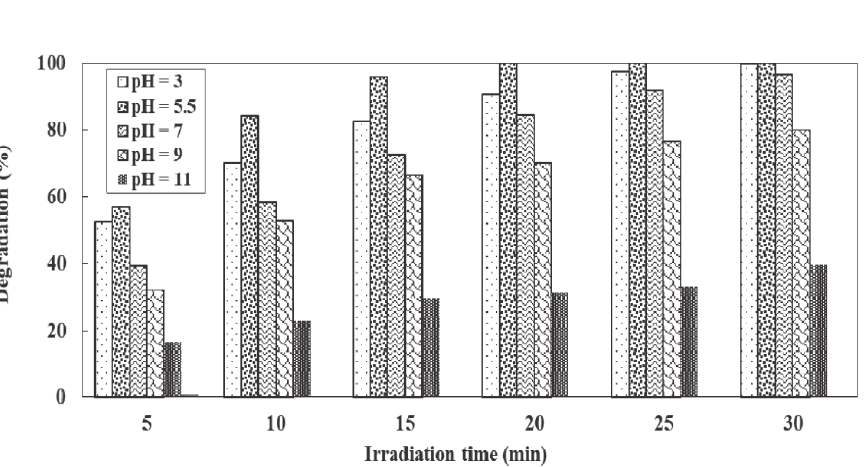
Fig. 9 – Effect of pH on the removal percent of PNP in the SDP. [PNP] = 20 mg L –1 , volume = 500 mL, [H rotation speed = 300 rpm, light intensity = 33 W m –2 , distance between lamps = 3.5